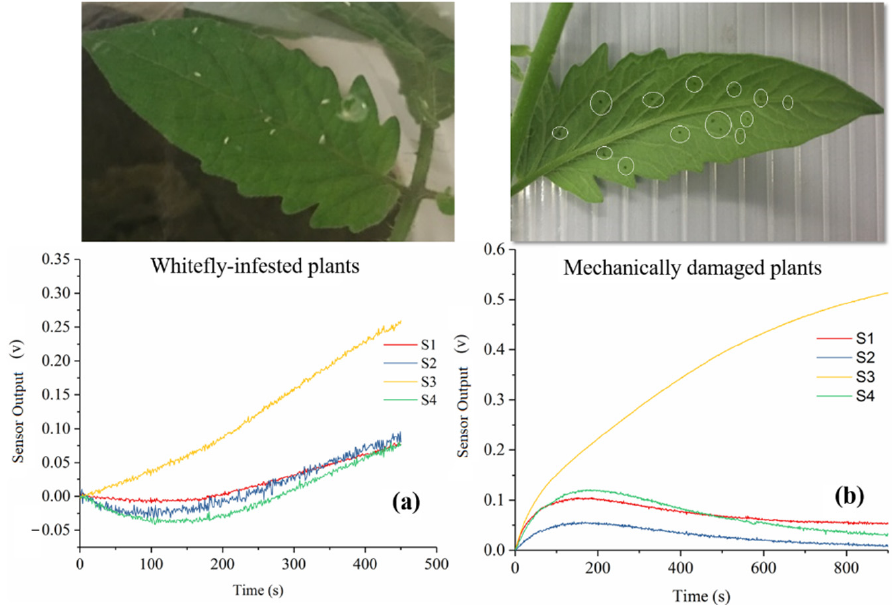
Figure 8. Sensor performance of E-nose system towards whitefly-infested plant ( a ) and mechanically damaged plant ( b ).